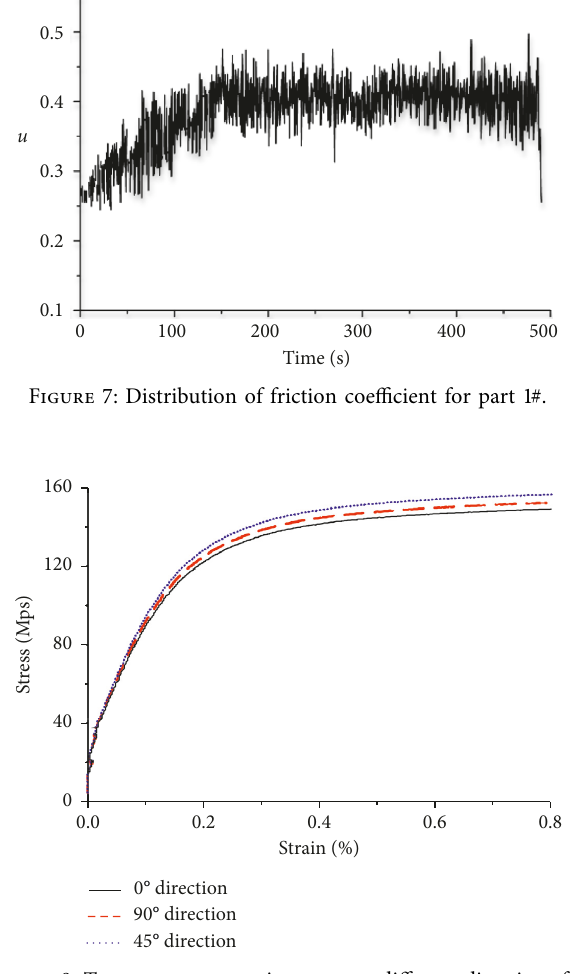
Figure 8: True stress-true strain curves at different directions for the 1060 aluminum.